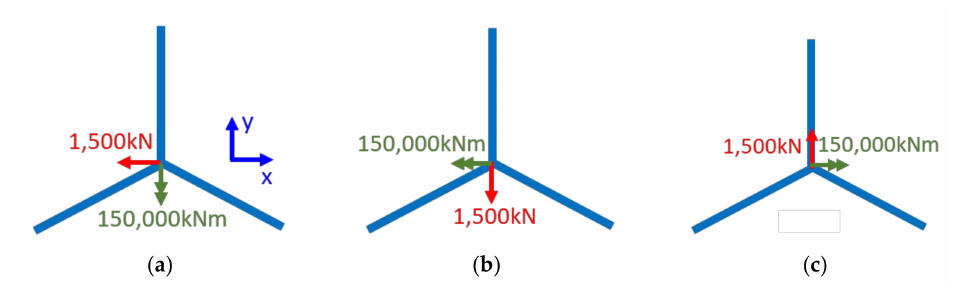
Figure 12. Loading scenarios illustrated on the tripod’s plane view: ( a ) loading scenario 1, ( b ) loading scenario 2 and ( c ) loading scenario 3.